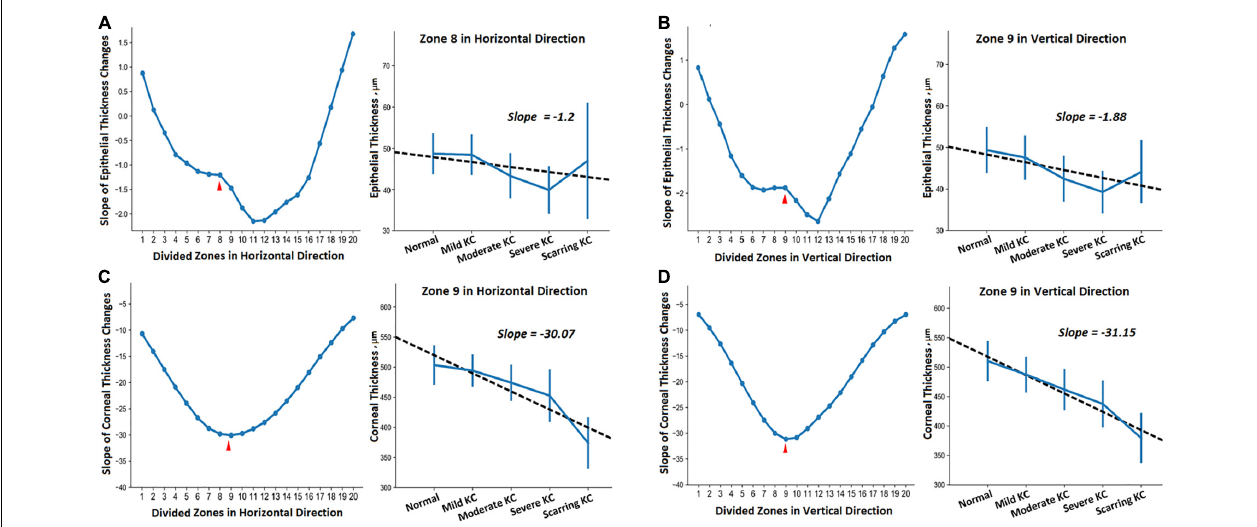
FIGURE 3 | The trends of the thickness change in different zones of the horizontal (A,C) and vertical (B,D) meridians between the normal and KC eyes in different stages. (A,B) Show epithelial thickness changes, while (C,D) show the corneal thickness changes. Each subgraph includes the fitted slopes in all divided zones and the detailed regression curve in one of the selected zones.